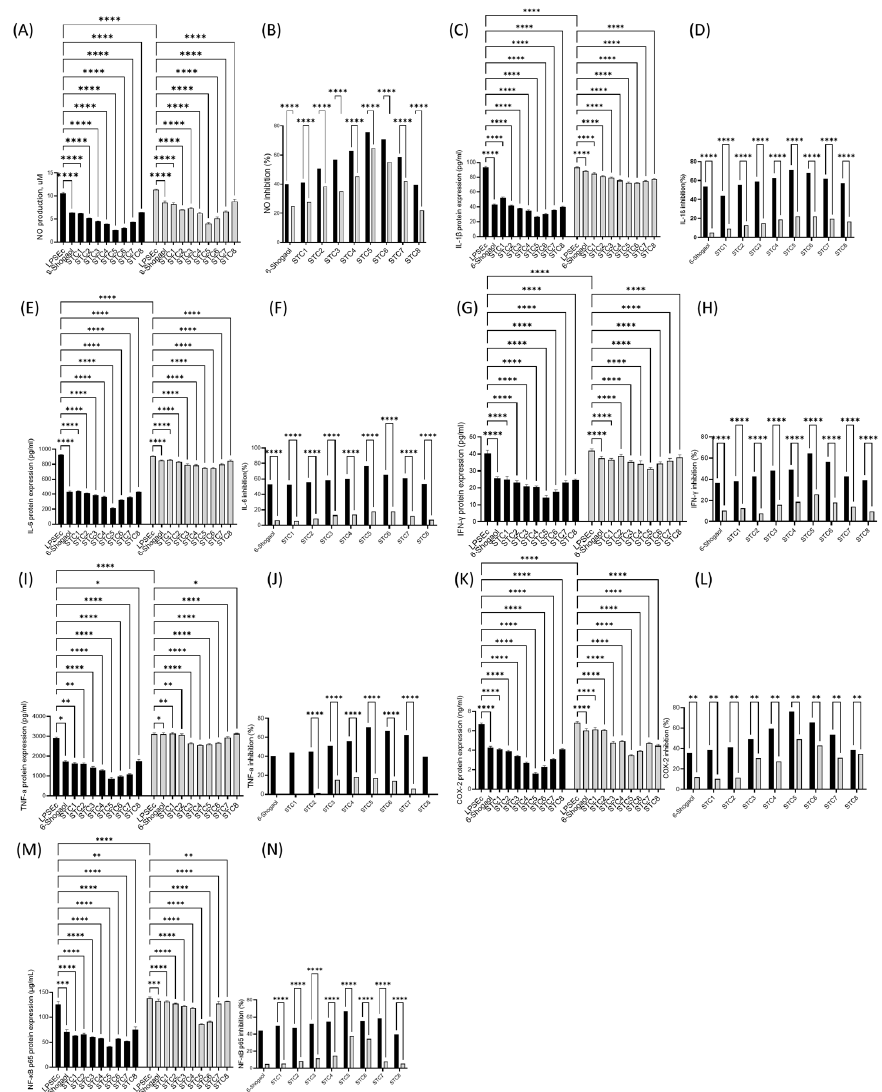
3.4. Effect of STCs on Anti-Inflammatory Markers and Mediators in BV-2 Cells The anti-inflammatory activity of STCs (at 1 µ M concentration) was assessed by measuring nitric oxide (NO), proinflammatory cytokines (IL-1 β , IL-6, IFN- γ , and TNF- α ), and inflammatory mediators (COX-2, and NF- κ B p65) production in LPS Ec -stimulated NRF2-Proficient and -silenced BV-2 cells (Figure 5). The ability of NRF2 siRNA to silence NRF2 in BV-2 cells was confirmed by comparing the NRF2 gene levels in control siRNA and NRF2 siRNA transfected BV-2 cells and NRF2-proficient BV-2 cells (the results are shown in the Supplementary Information).